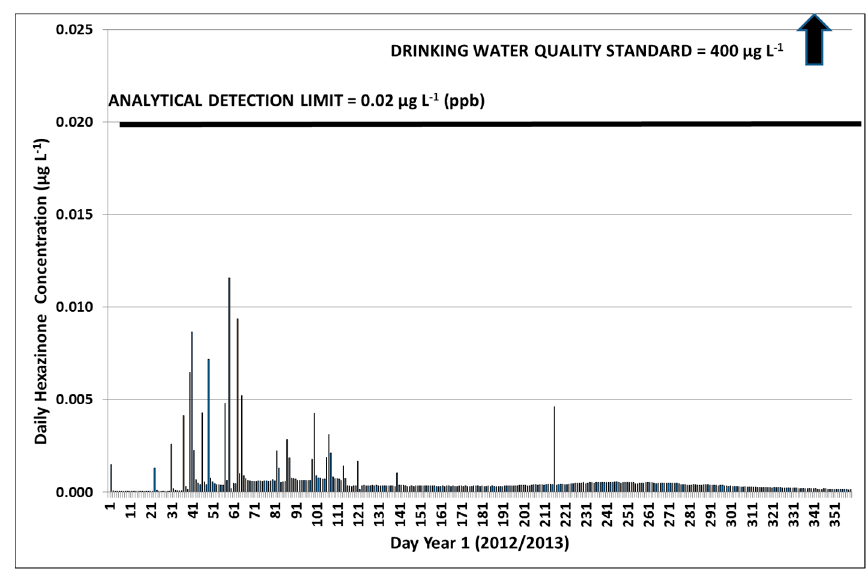
Figure 7. Year 1—modeled daily average concentrations of hexazinone in the Rangitaiki River at the Rangitaiki flow gauge.